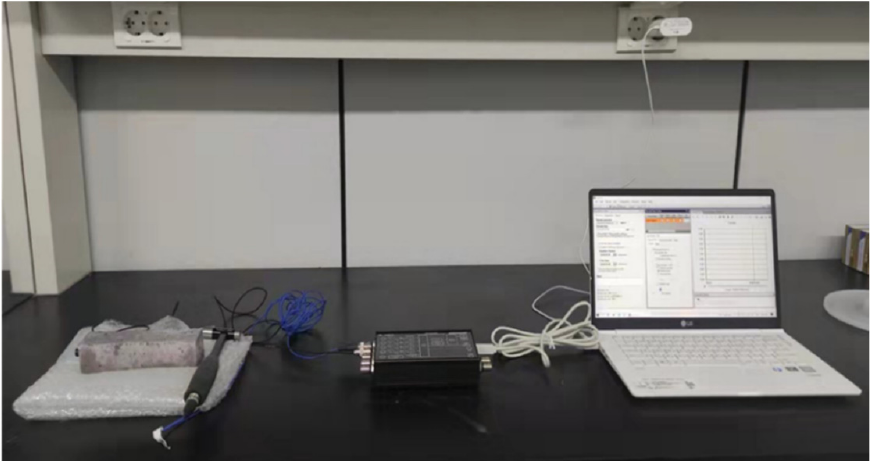
Figure 2. A picture of the damping ratio test setup.